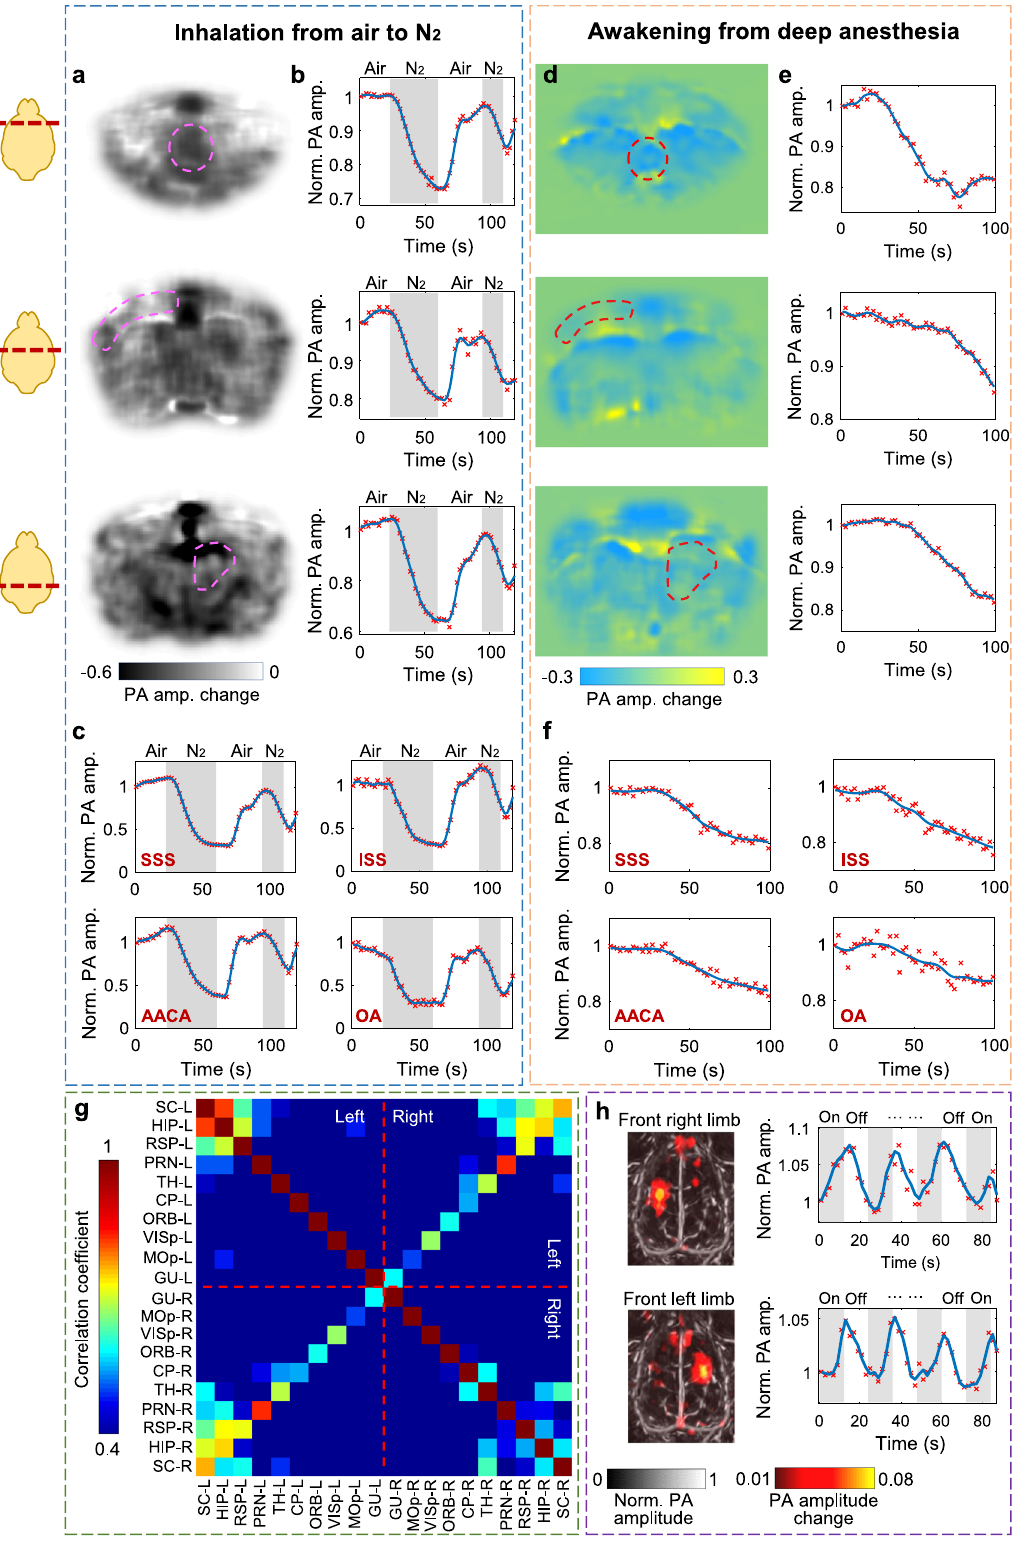
in individual vessels. Although the rat brain can be fi xed in place during imaging using a nose cone and tooth bar, artefacts induced by periodic motions (e.g., breathing) can be largely removed by time-gated motion correction (see Methods). We have demon- strated this technique by imaging the abdomen of a pregnant rat, whose embryo was clearly revealed after correcting the